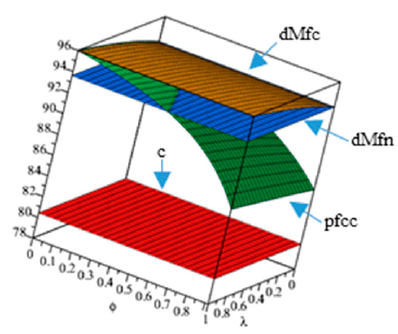
Figure 5. Effects of fairness concerns and profit-sharing on retail price.